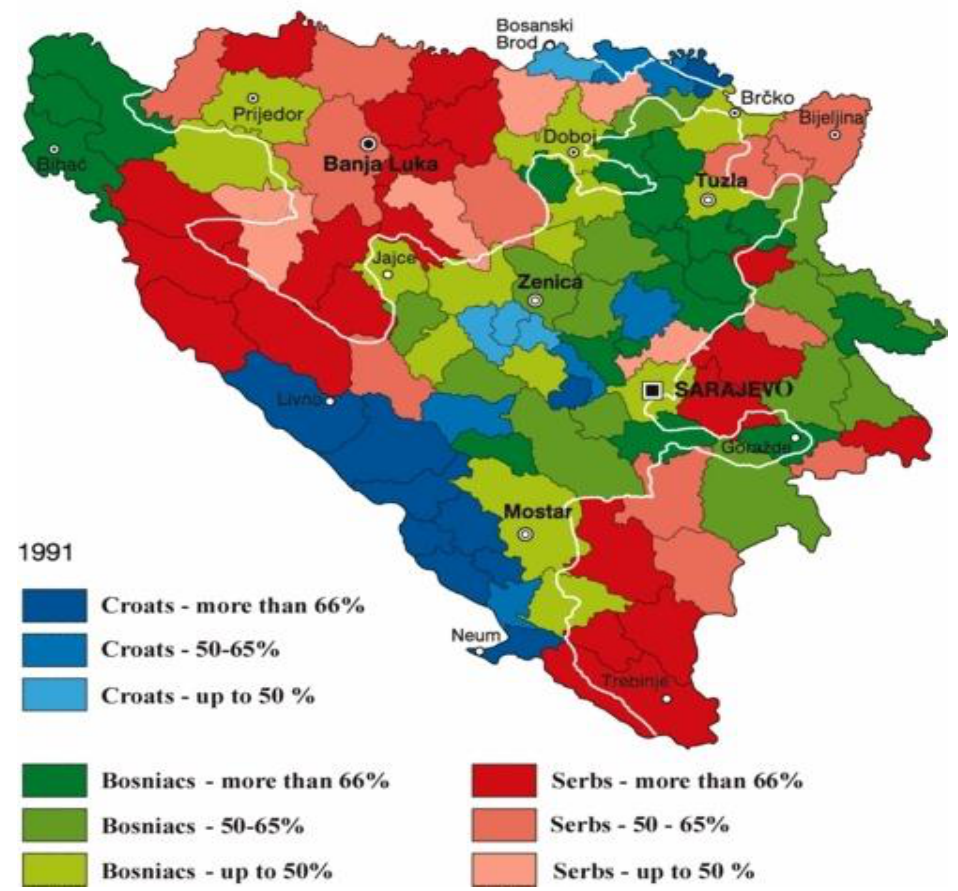
Fig. 1. Ethnic composition in Bosnia in 1991, before the war. Source: Čuvalo 2007, p.